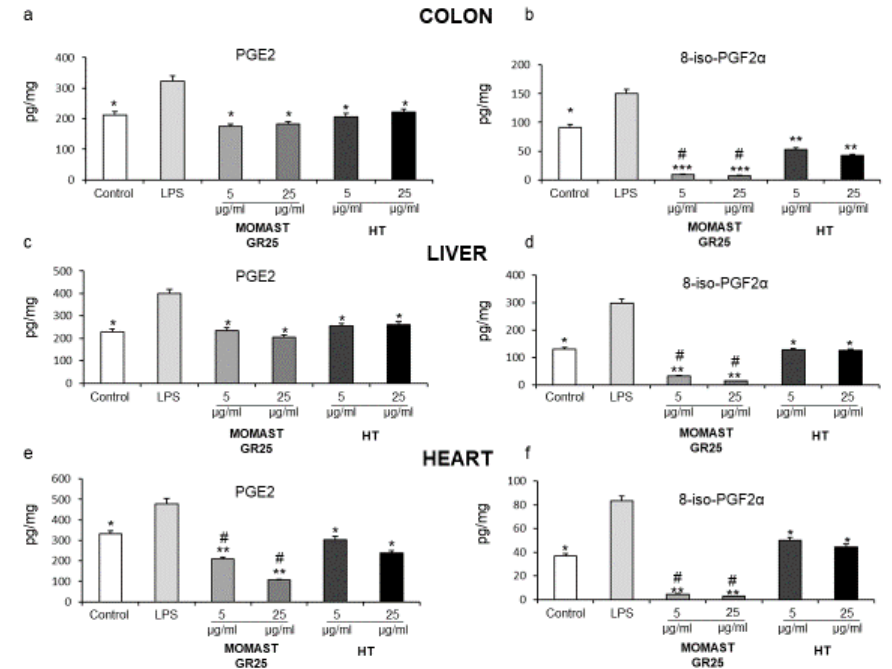
Figure 1. Effects of MOMAST ® GR25 (5 and 25 µg/mL) on prostaglandin (PG)E 2 and 8-iso-PGF 2α levels (pg/mg wet tissue) in rat colon ( a , b ), liver ( c , d ), and heart ( e , f ) specimens. Data were reported as means ± SEM. One-way analysis of variance (ANOVA), p < 0.01; post-hoc test, * p < 0.05, ** p < 0.01 and *** p < 0.005 vs. LPS-treated group: # p < 0.005 vs. HT